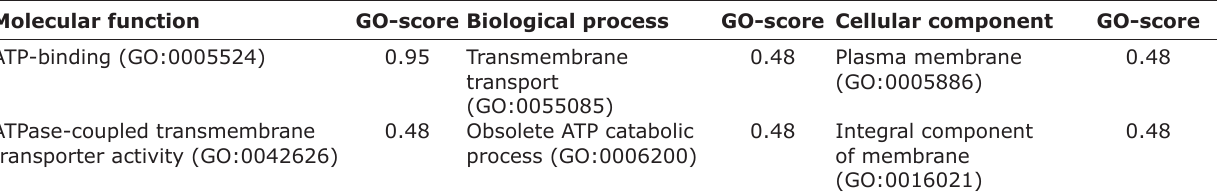
Table-4: The gene ontology of the T. evansi MRPE protein. Molecular function